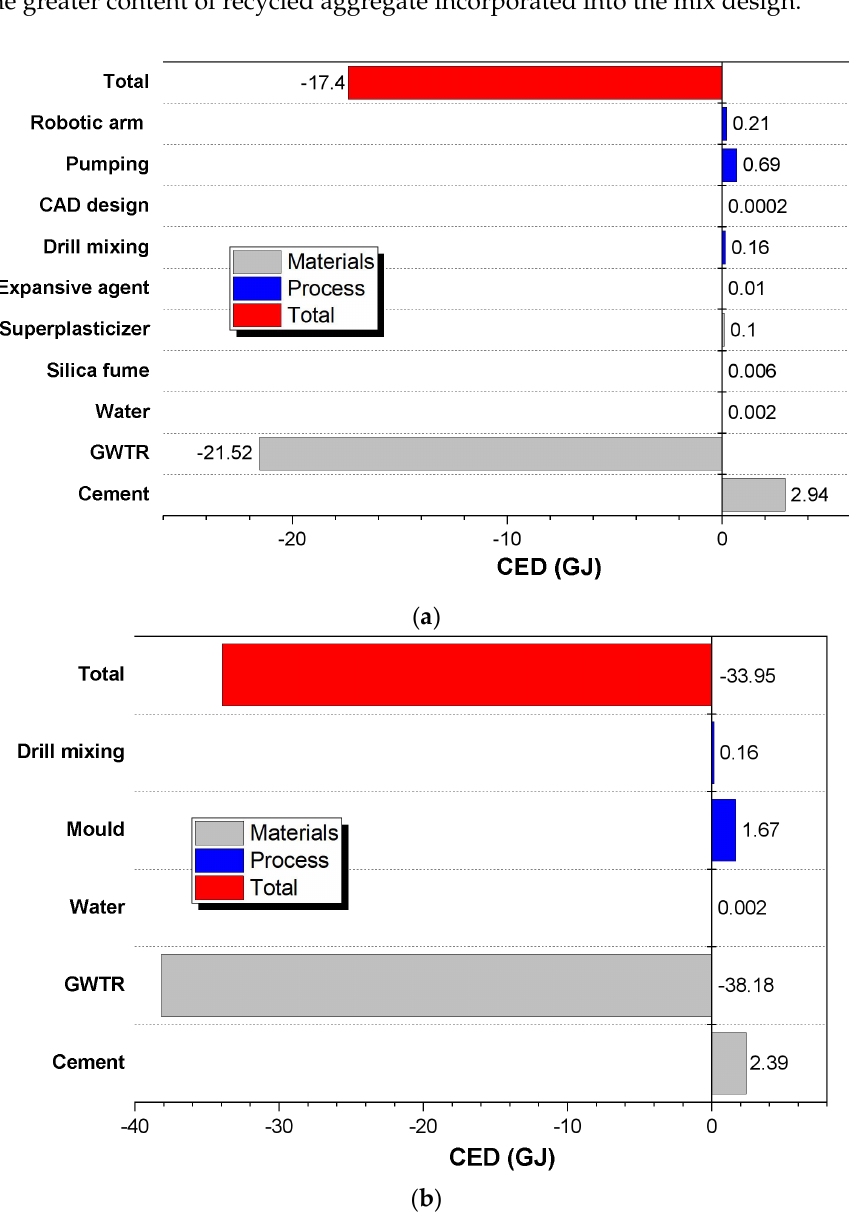
Figure 5. CED results: ( a ) p-RuC and ( b ) c-RuC .